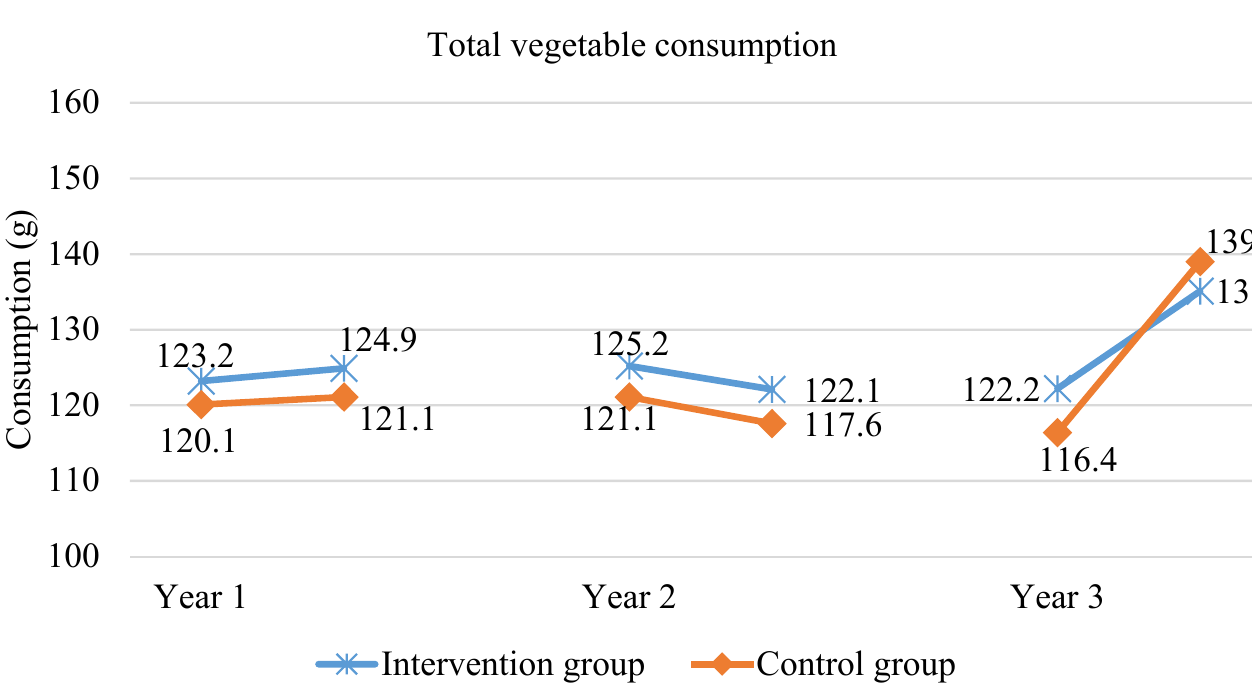
Figure 2. Vegetable consumption (on both school and weekend days) during the three years of the study.